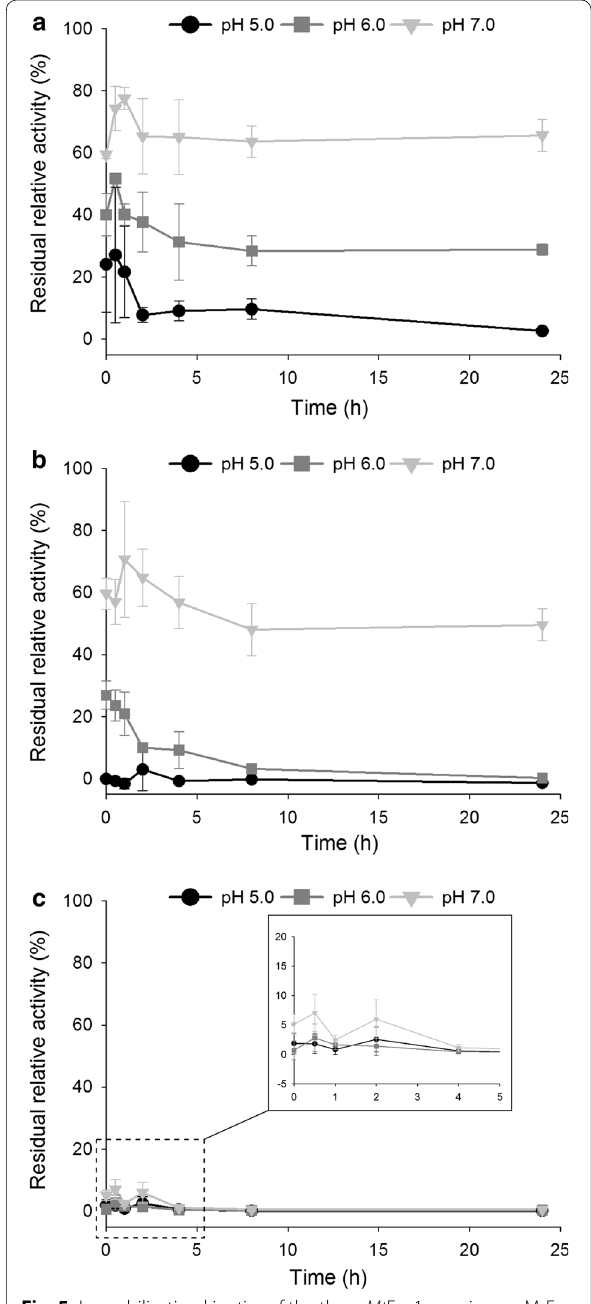
Fig. 5 Immobilization kinetics of the three Mt Fae1a versions. a M‑Fae. b P‑Fae. c E‑Fae, the inlay shows an enlargement of the first 5 h of adsorption. Adsorption of M‑Fae, P‑Fae and E‑Fae in mesoporous silica particles was followed for 24 h in sodium phosphate. The results are presented as the enzymatic activity in the supernatant relative to the activity measured in a sample that had not been in contact